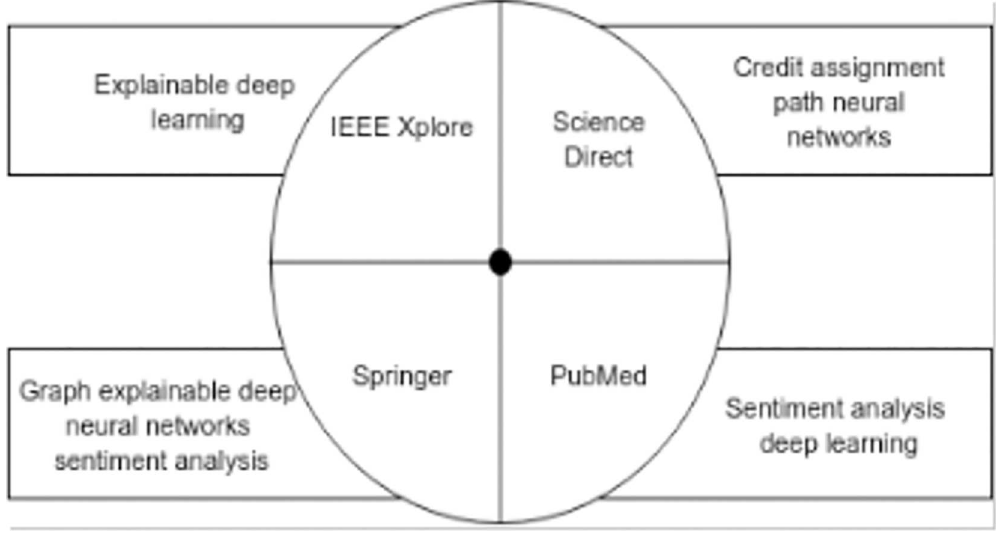
Fig 2. Research databases and